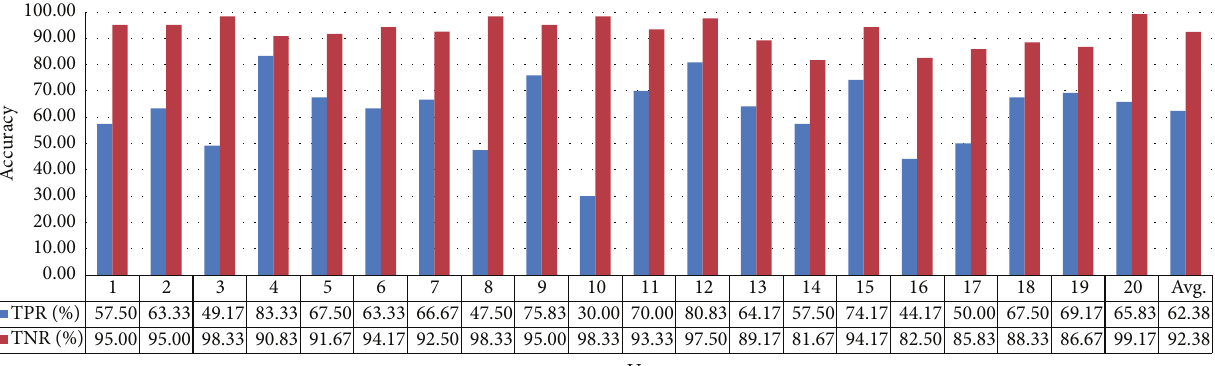
Figure 18: Accuracy of selecting the 60-inch television using gaze estimation method 2.